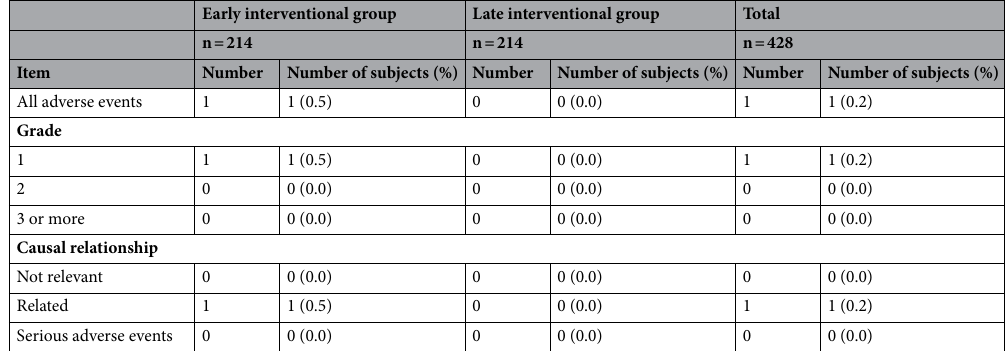
Table 5. The occurrence of adverse events